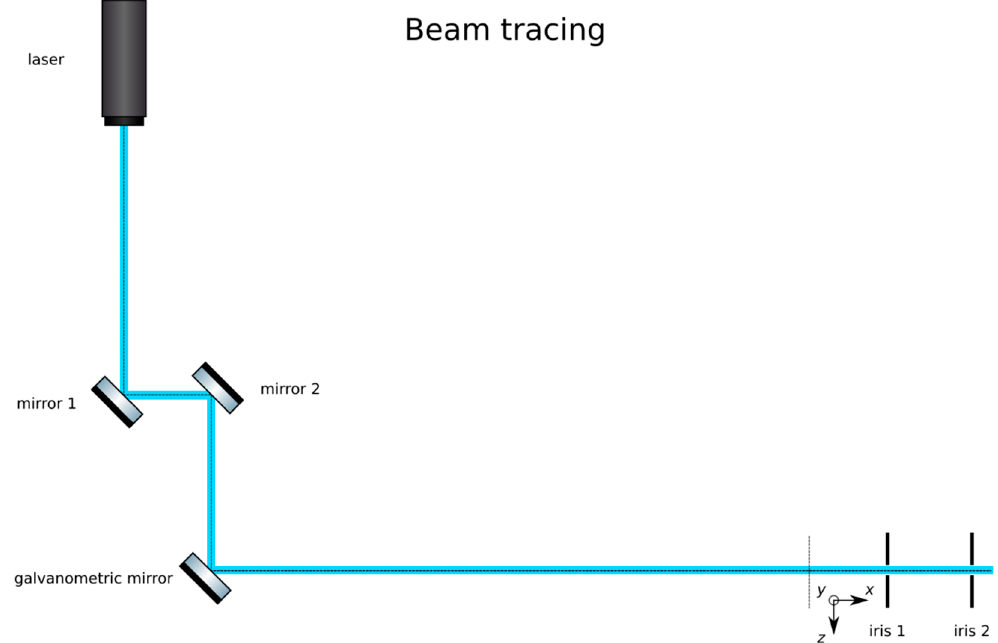
Figure 2. Tracing the beam path with a pair of mirrors, the galvanometric mirror. Record the path with a pair of irises.